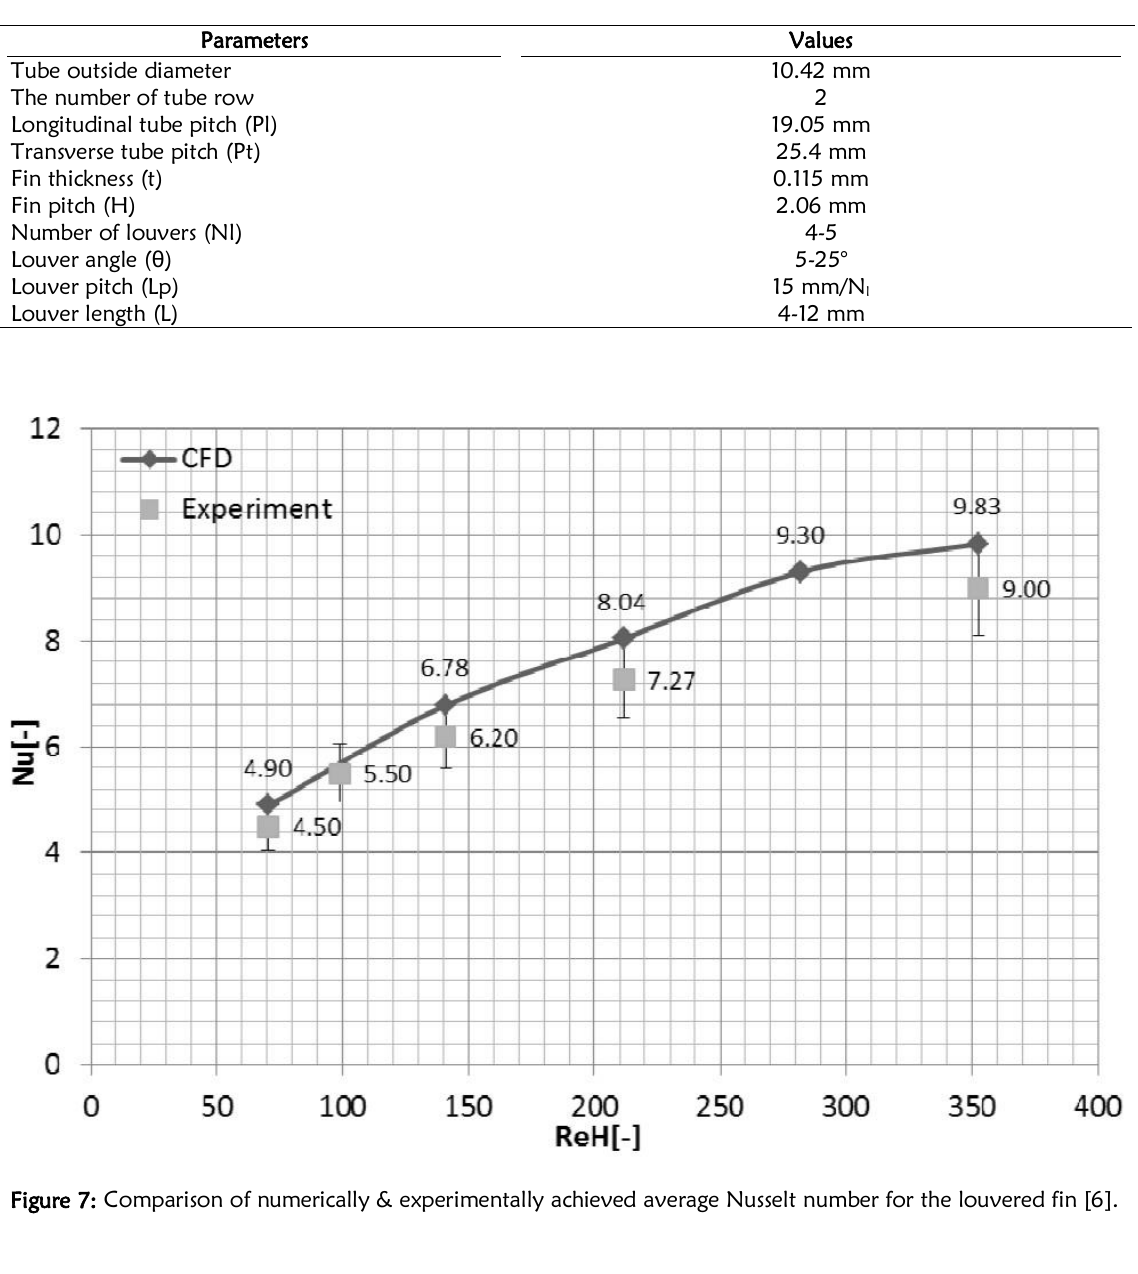
Table 2: The detailed geometry of the examined heat exchangers [6].